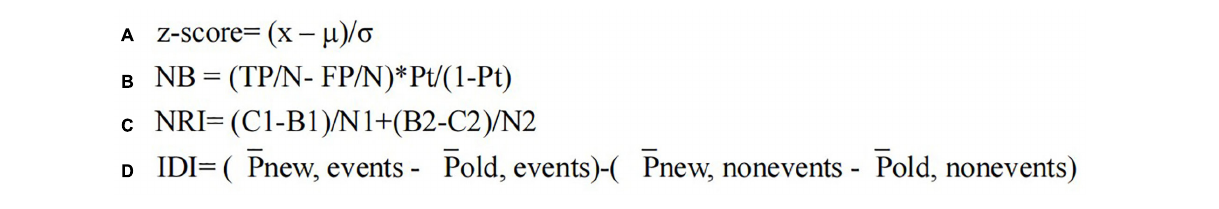
FIGURE 1 | Formulas of z -score (A) , net benefit (B) , net reclassification index (C) , and integrated discrimination index (D) . x , the feature value; µ , the average of the feature values among all VOIs; σ , the corresponding standard deviation; NB, net benefit; TP, true positive; FP, false positive; N , total cases; Pt, probability threshold; NRI, net reclassification index; C1, B1, the cases predicted by the new and old model in the event occurrence group; B2, C2, the cases predicted by the new and old model in the event incurrence group; N1, N2, the cases in the event occurrence and incurrence group; IDI, integrated discrimination index; − Pnew, events, − Pold, events, the mean of the probability of disease predicted by the new and old model for each individual in the event occurrence group; Pnew, non-events, − Pold, non-events, the mean of the probability of disease predicted by the new and old model for each individual in the event incurrence group.